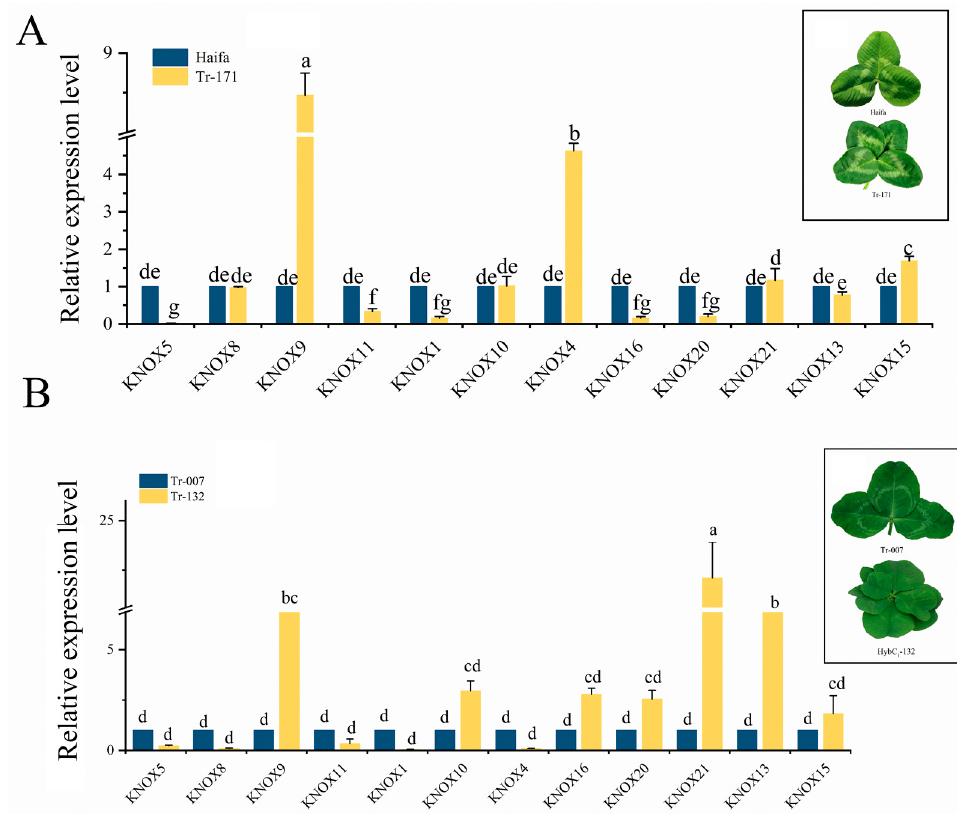
Figure 8. The relative expression of 12 TrKNOX genes of leaf development in T. repens with different leaf types. ( A ) 12 gene expression patterns of the TrKNOX family in Haifa and Tr-171. ( B ) 12 gene expression patterns of the TrKNOX family in Tr-007 and HybC1-132. Error bars were obtained from three measurements. Each value is the mean ± SD of three biological replicates; different letters above bars indicate statistically significant difference at p < 0.05.